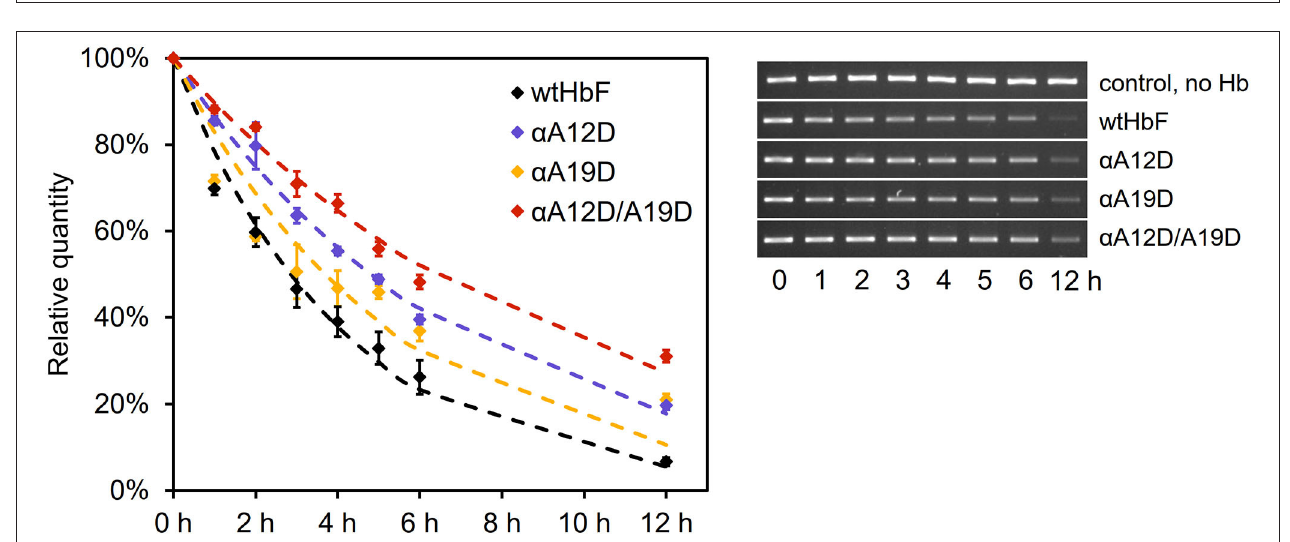
FIGURE 2 | Chromatogram of the elution step of wtHbF and mutants α A12D, α A19D, and α A12D/A19D on a HiTrap Q HP column. The column was equilibrated with 20mM Tris-HCl pH 7.4 and the dashed line shows the change in conductivity (mS/cm) as the NaCl concentration was increased over a linear gradient.